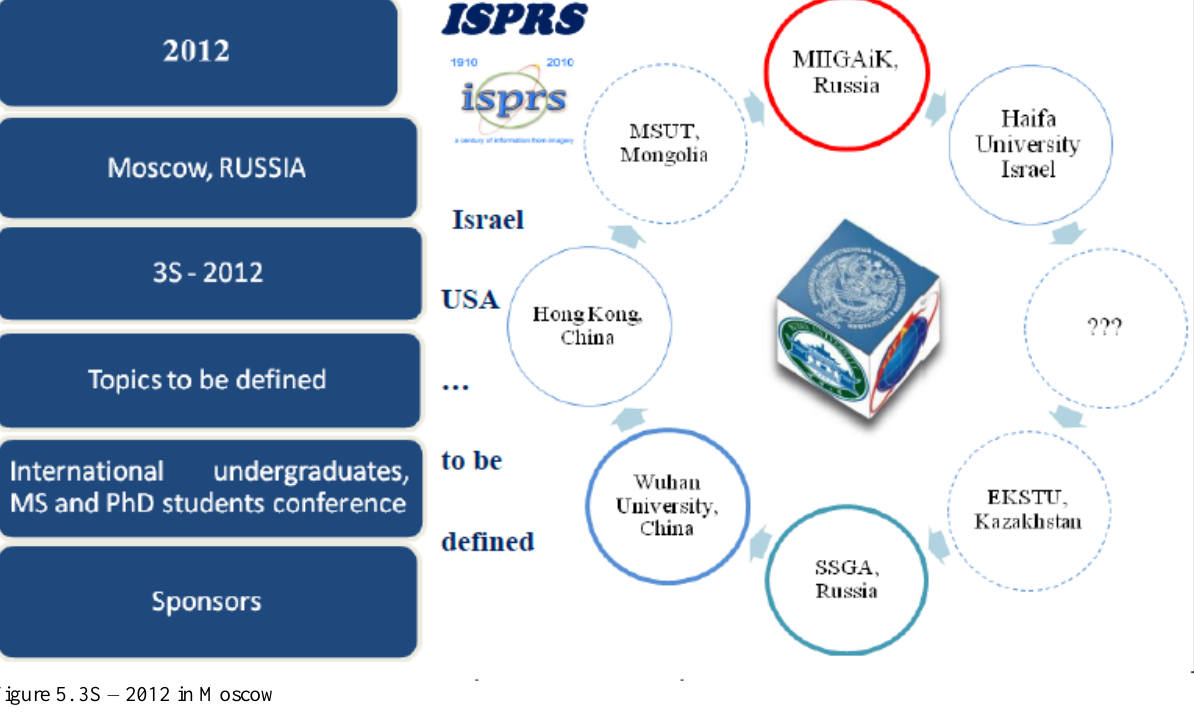
Figure 5. 3S – 2012 in Moscow in 2013, parallel to the 3S-2013 so it would be possible to attract more potential